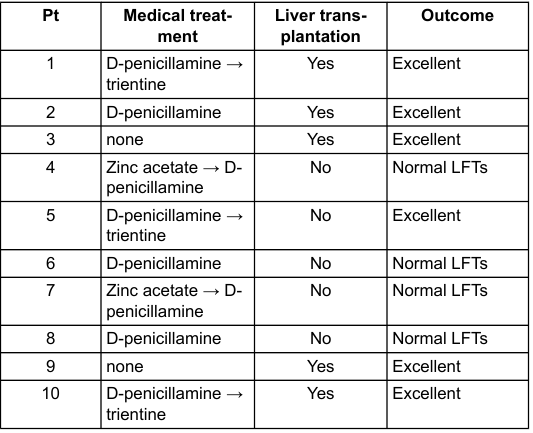
Table 4: Management and outcome of patients with Wilson’s disease.